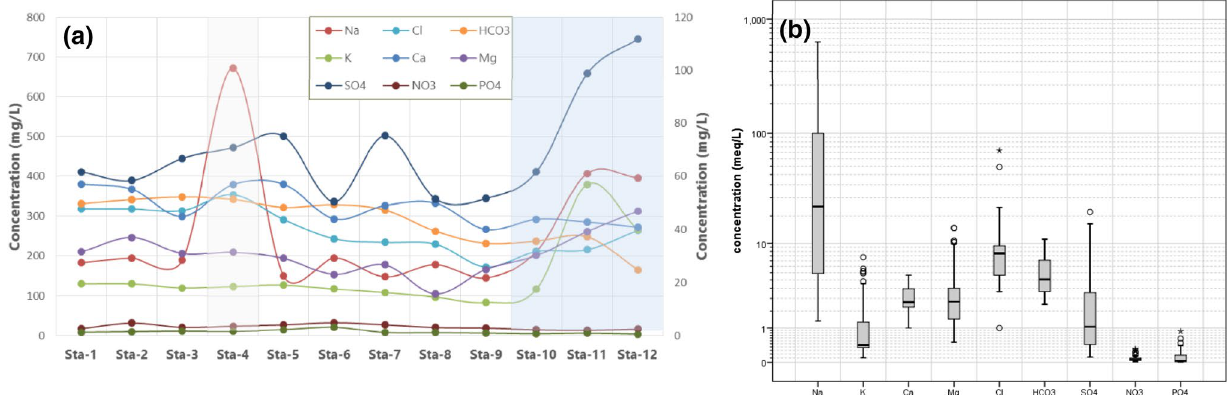
Fig. 3 Distribution of major ions in Mayur River basin: a spatial distribution from north to south; b overall variations in Box–Whisker’s plot. The figure does not include samples from the adjoining